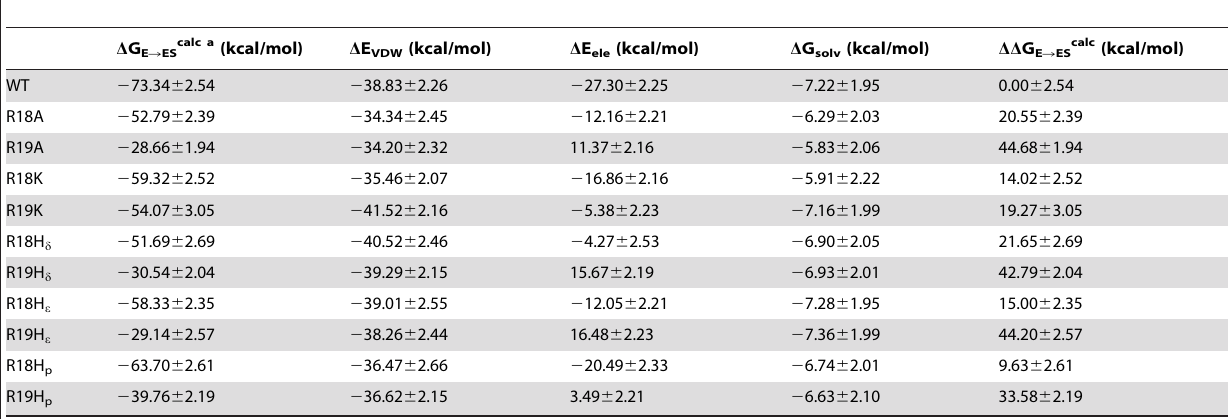
Table 4. Predicted relative MM-GBSA free energies (kcal/mol) and individual energy terms of the complexes between mutant peptides derived from Kemptide and